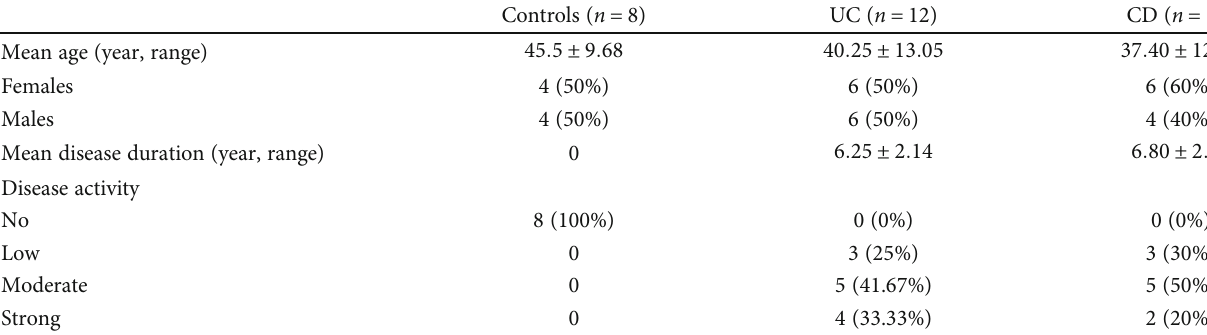
Table 1: Patient characteristics of human samples.